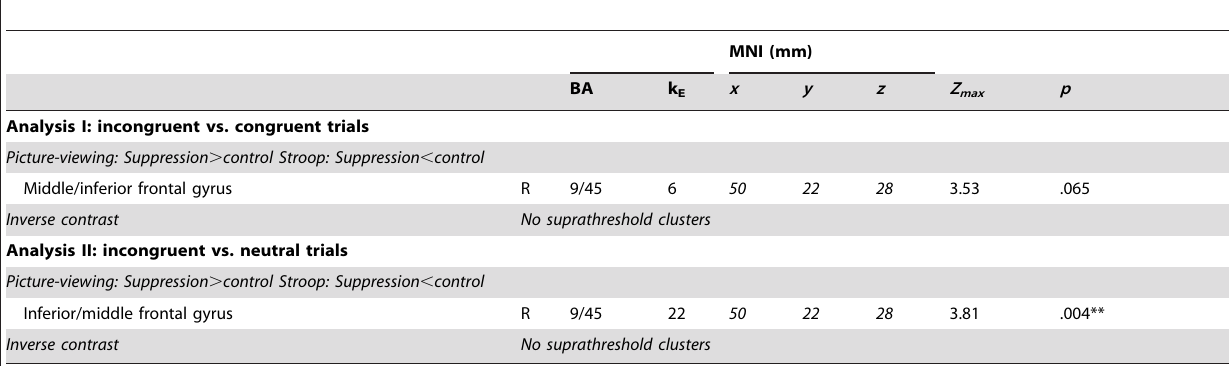
Table 1. Results within the functionally defined prefrontal search volume for the interaction between activity during the picture- viewing and the Stroop task for different types of analyses.